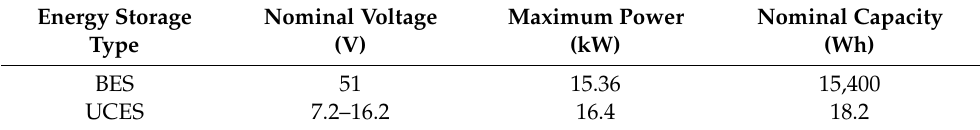
Table 2. Specification of the ESSs.